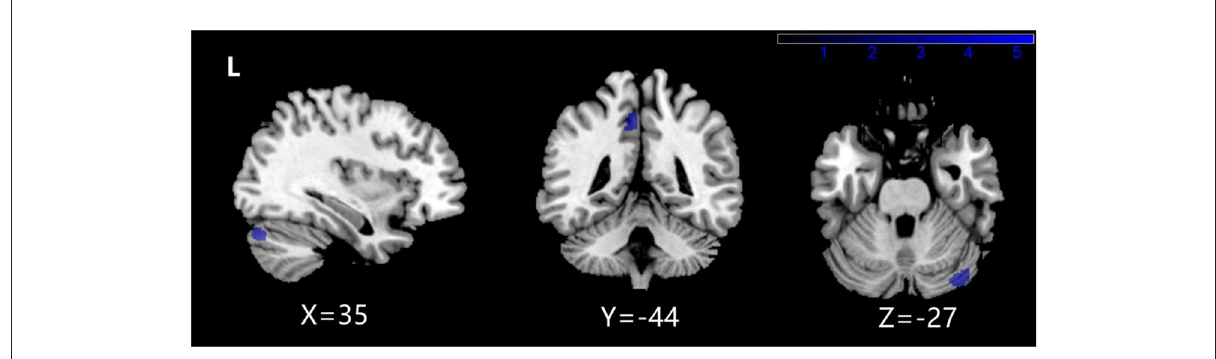
FIGURE2 Brain regions with a significantly decreased volume of gray matter in NMDARE_LD compared to